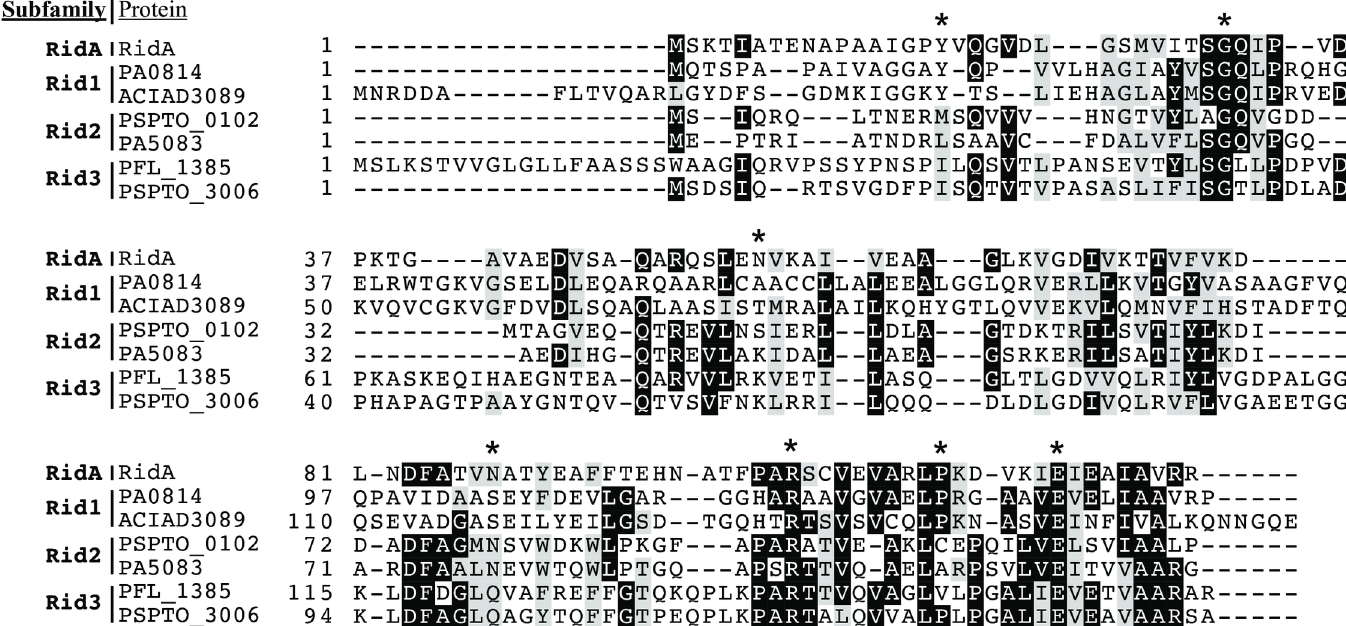
Fig 2. Sequence alignment of Rid proteins. Amino acid sequencesof the Rid proteins used in this study are alignedand groupedby subfamily (RidA or Rid1-3). Similar residuesare boxedin grey and identicalresidues are boxedin black. Active site residues proposed for S . enterica RidA are marked with asterisks. The amino acid sequenceswere alignedusing Clustal Omega [39] and residues were shadedusing the ExPASy BoxShadeserver.